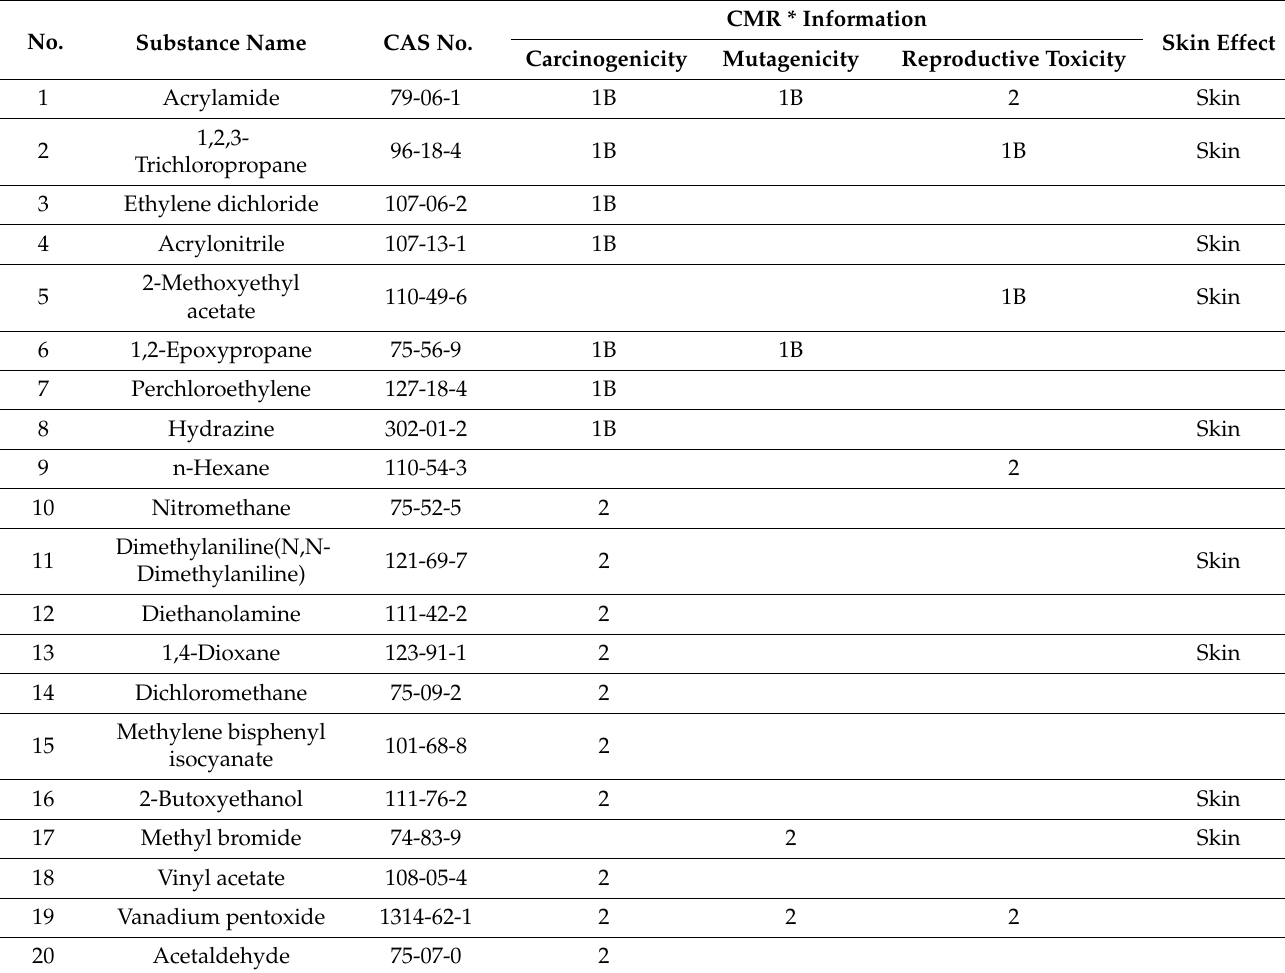
Table 1. Hazards of chemical substances requiring management in a workplace